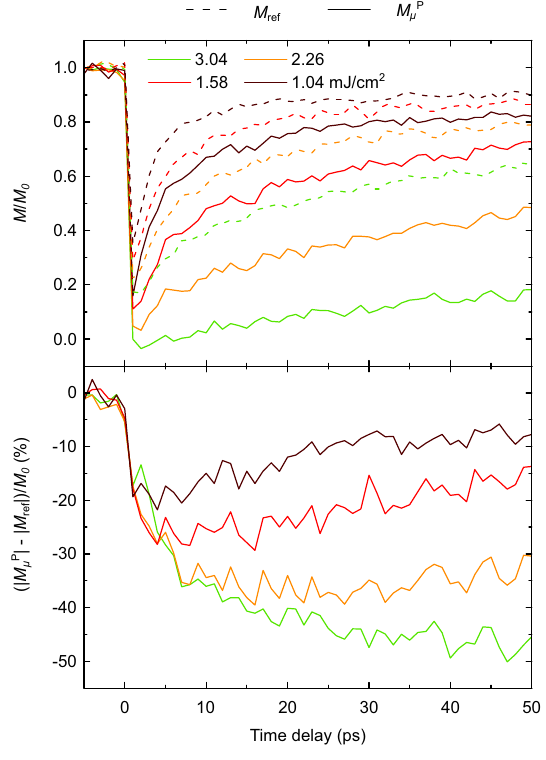
Fig. 4 | Experimental observation of ultrafast spin cooling and heating in the [Co/Pt] ferromagnetic multilayer. a The top panel compares the magnetization dynamics in the reference sample M ref (dashed line) with the magnetization dynamics of the free [Co/Pt] ferromagnetic multilayer in the spin-valve sample in theAPcon fi guration M AP μ (solidline).Thebottompanelshowstheeffectofthespin current generated by the GdFeCo layer on the magnetization dynamics of the free [Co/Pt], i.e., ð ∣ M AP μ ∣ (cid:2) ∣ M ref ∣ Þ = M 0 . b The top panel compares the magnetization dynamics in the reference sample M ref (dashed line) with the magnetization